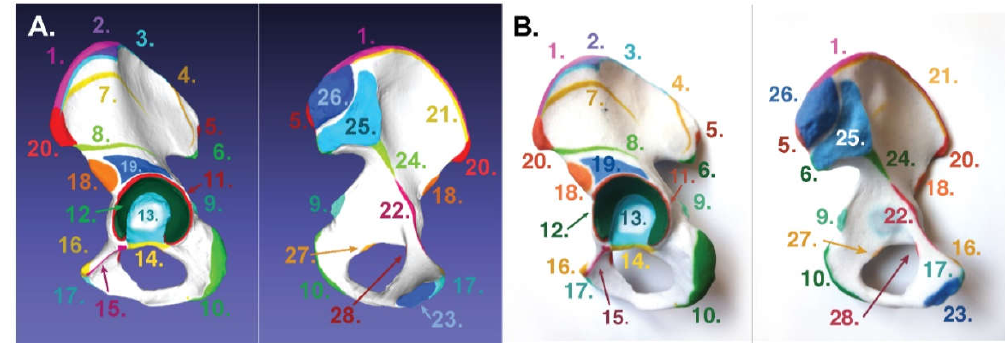
shows the superior view, left shows the dorsal view, and right shows the ventral view of scapula.